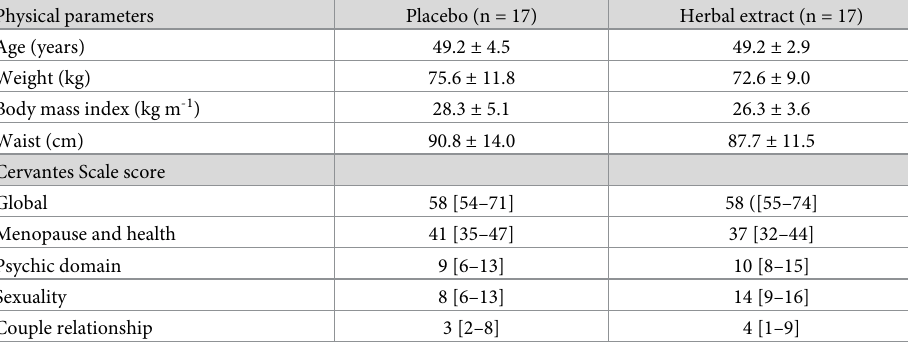
Table 1. Baseline characteristics of the women enrolled in the study.